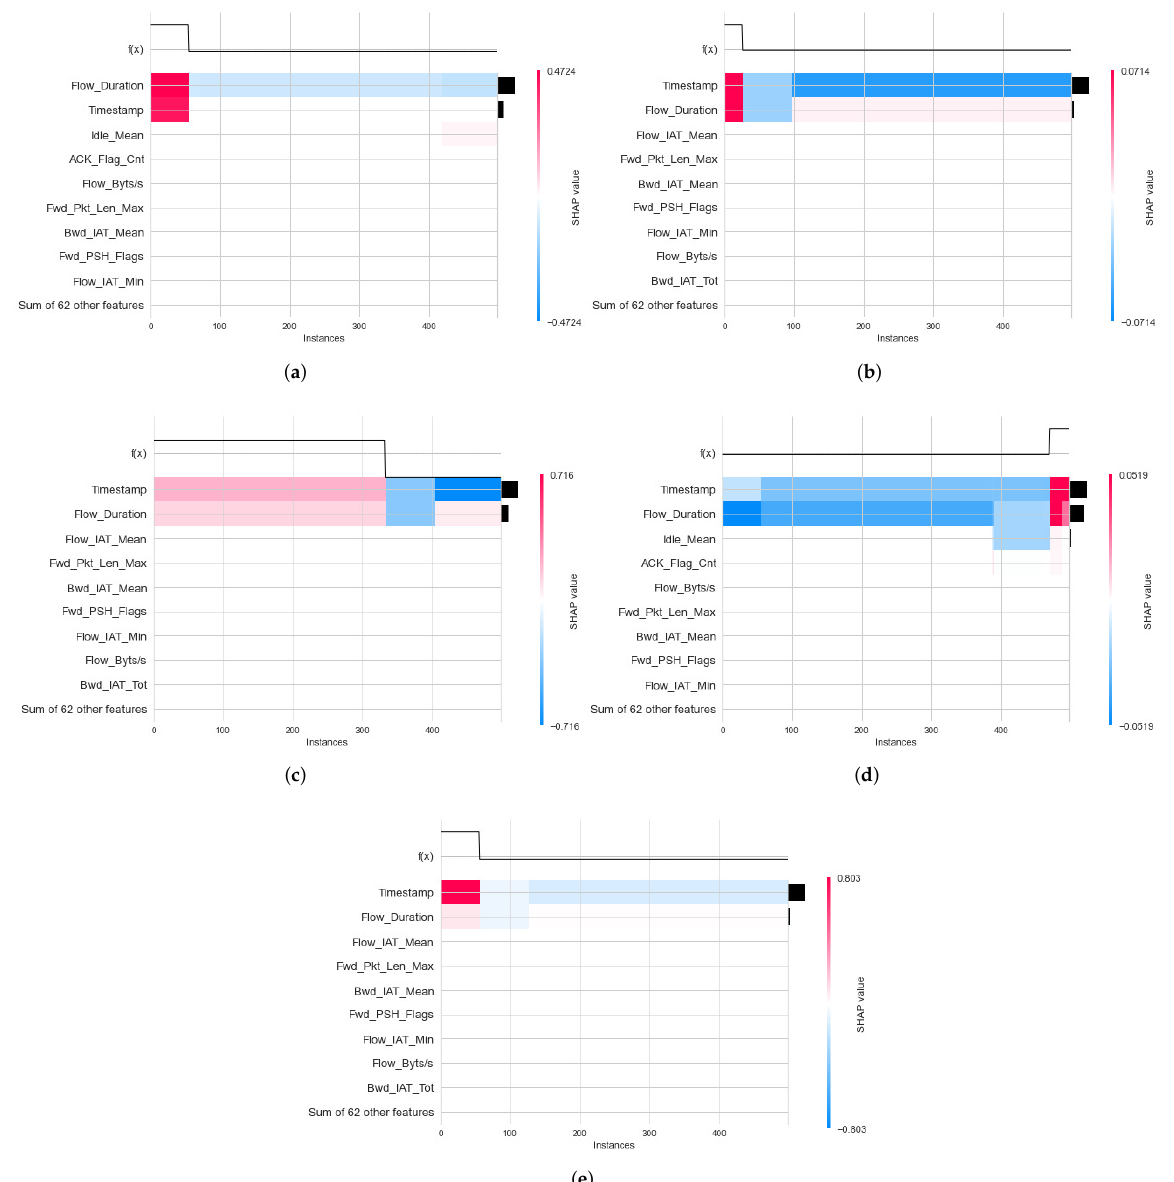
Figure 11. Heatmap curve results of global explanation for IoTID20 dataset in five Cat output values: ( a ) 0—MITM ARP Spoofing; ( b ) 1—Scan; ( c ) 2—DoS; ( d ) 3—Mirai; ( e )